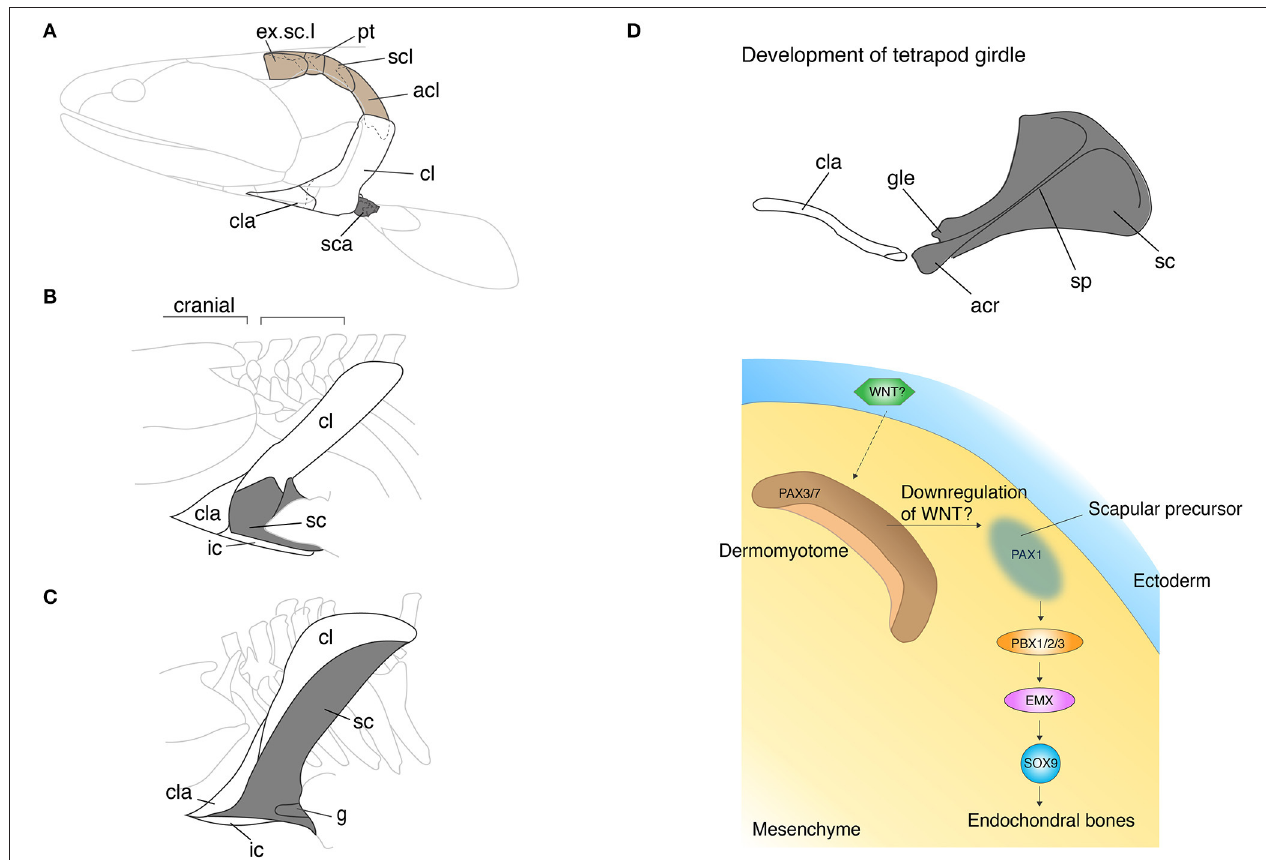
FIGURE 2 | The skeletal shift from dermal to endochondral bones in the pectoral shoulder girdles. (A–C) The pectoral girdles of Eusthenopteron (A) , Ichthyostega (B) , Eryops (C) . Brown shaded bones (extrascapular, post-temporal, supracleithrum, and anocleithrum) in (A) have been lost during the fish-to-tetrapod transition. Shaded bones depict endochondral bones. Note that the endochondral bones have enlarged with the concomitant decrease of the dermal bones. In (B,C) , the spaces between the skull and pectoral girdle demonstrate the origin of the neck. (D) The developmental mechanisms of the scapula in mouse and chicken embryos. The epithelial-mesenchymal transition produces prospective scapular cells from the dermomyotome. The understanding of developmental programs underlying the dermal bone development is still poor (see text). acl, anocleithrum; acr, acromion; cl, cleithrum; cla, clavicle; g, glenoid fossa; ic, interclavicle; sc, scapula; sca, scapulocoracoid; scl, supracleithrum; sp, spine; Illustrations in (A–C) are redrawn with permissions form Andrews and Westoll (1970), Jarvik (1980), and Gregory (1951) . The illustration of the mouse scapula is adapted with permission from Kuijper et al.